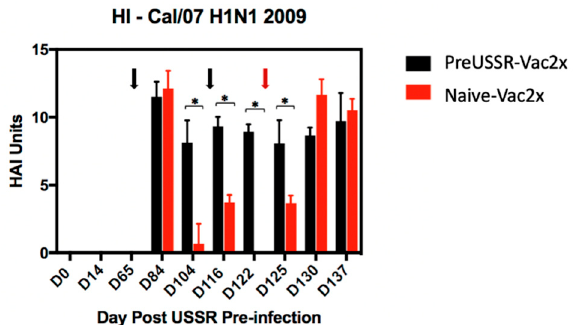
Figure 6. Focused titer analysis of the H1-2009 specific antibodies elicited in the PreUSSR-Vac2x and Naïve-Vac2x groups. HAI assay utilizing serum collected throughout the time course for the preUSSR-Vac2x and Naïve-Vac2x groups against the 2009 H1N1 pandemic Cal / 09 virus are graphed to better visualize quantitative and statistical di ff erences based on the contribution of preimmunity. Black arrows denote time of vaccination. Red arrow denotes the challenge day. Day 0 is the time of infection with the seasonal H1N1 USSR / 77 virus. Values are graphed in HAI Units. * indicates a p -value of less than 0.05 as determined by Student’s t